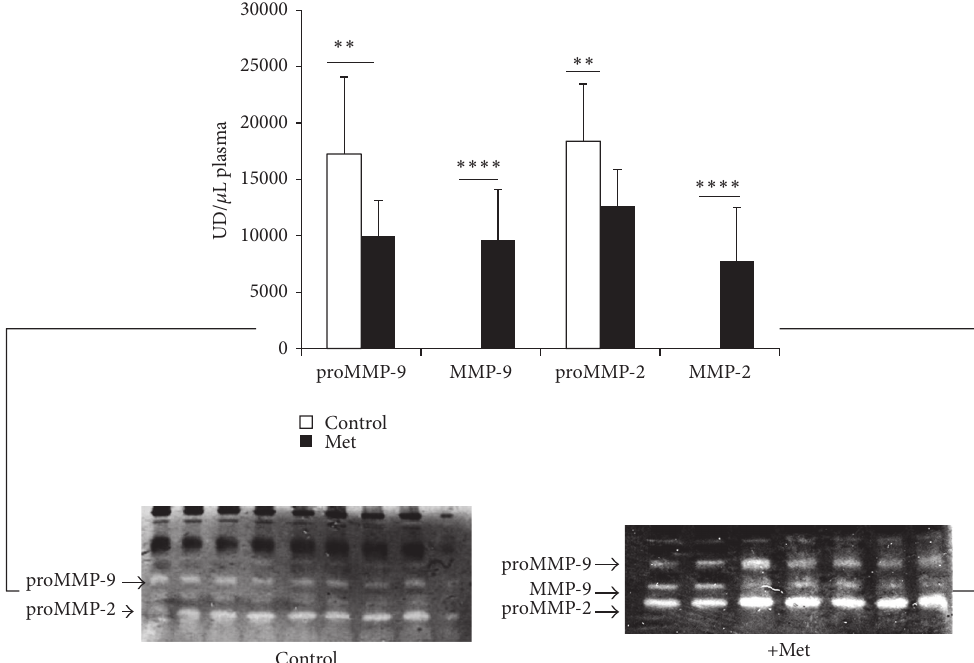
Figure 11: Plasma MMPs activities of newborn rabbit. Control: offspring from control female rabbit (PC); Met: offspring from female rabbit submitted to Met (PMet) ( ∗∗ 𝑝 < 0.01 , ∗∗∗∗ 𝑝 < 0.0001